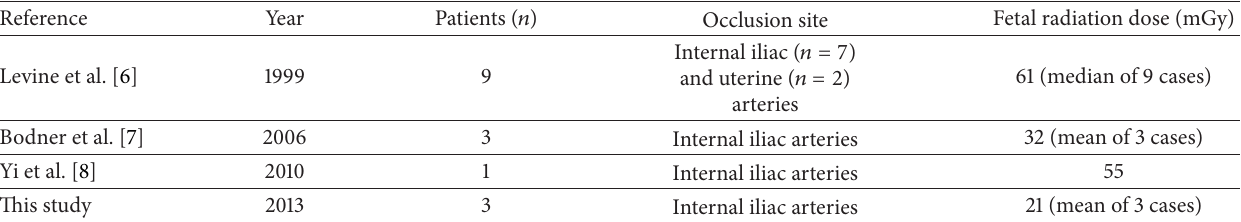
Table 6: Summary of studies of the fetal radiation dose from prophylactic balloon